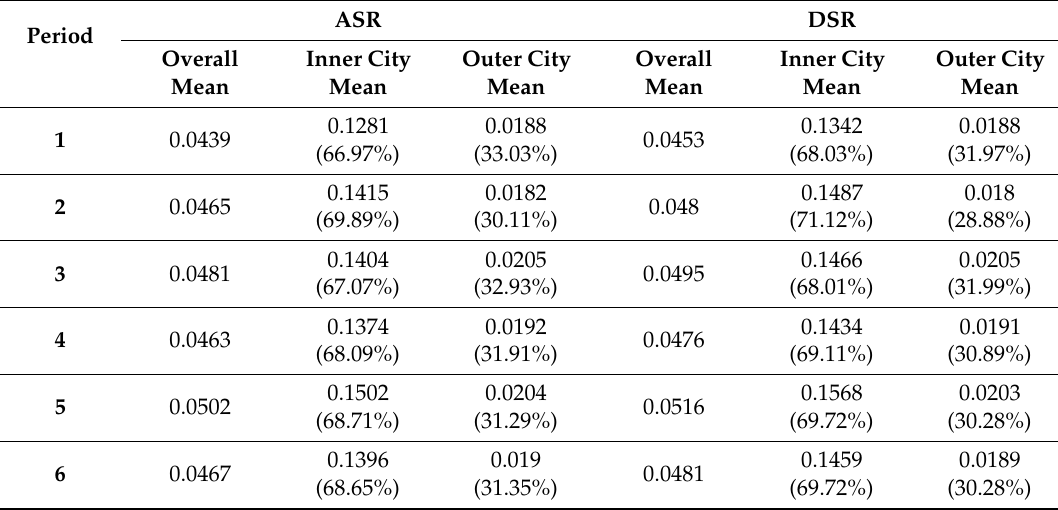
Table 4. The overall mean of the ASR/DSR, the inner city mean of the ASR/DSR, and the outer city mean of the ASR/DSR on